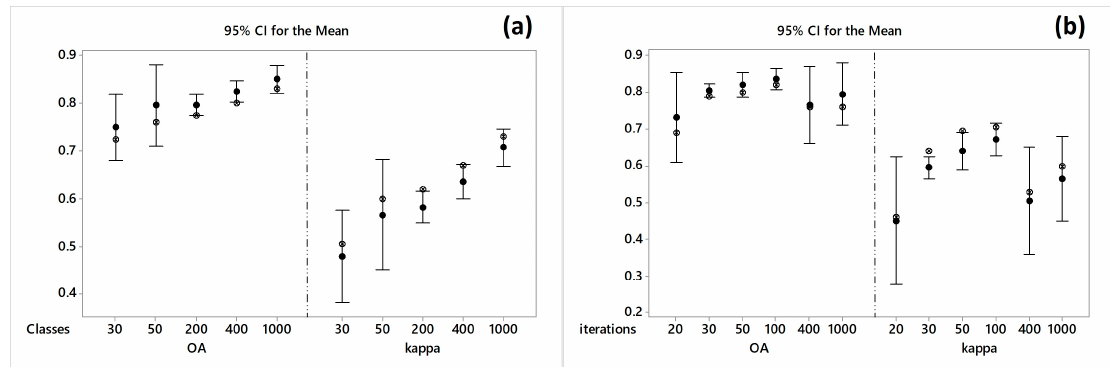
Figure 5. Interval plots from the pairwise post hoc test after applying the global approach variance analyses. ( a ) OA and kappa interval plots by the number of classes for the k-means; ( b ) OA and kappa interval plots by the number of iterations for the k-means. The circle with a cross inside represents the median values.